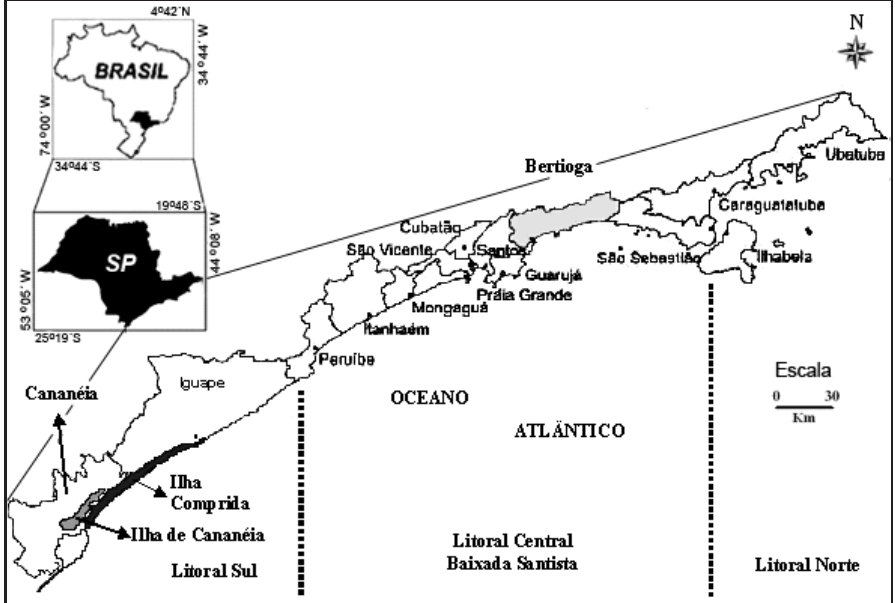
Figura 1. Localização dos municípios de Bertioga, Cananeia e Ilha Comprida no litoral do Estado de São